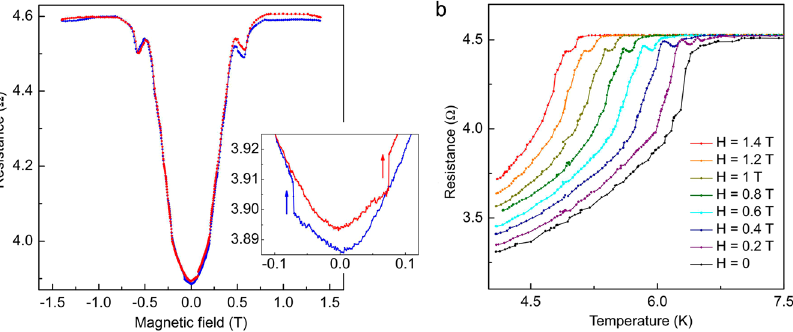
Figure 3. ( a ) Magnetoresistance R ( H ) measured at T = 6 K. The inset shows magnified R ( H ) curves in the vicinity of H c . Red and blue colors correspond to positive and negative sweep of the magnetic field. Arrows indicate direction of nanowire magnetization reversal. ( b ) Evolution of the temperature dependencies of resistance of the Ni nanowire for different applied magnetic fields. The peak effect close to T C could be related to the spin accumulation at the Nb/Ni interface (see explanation in the